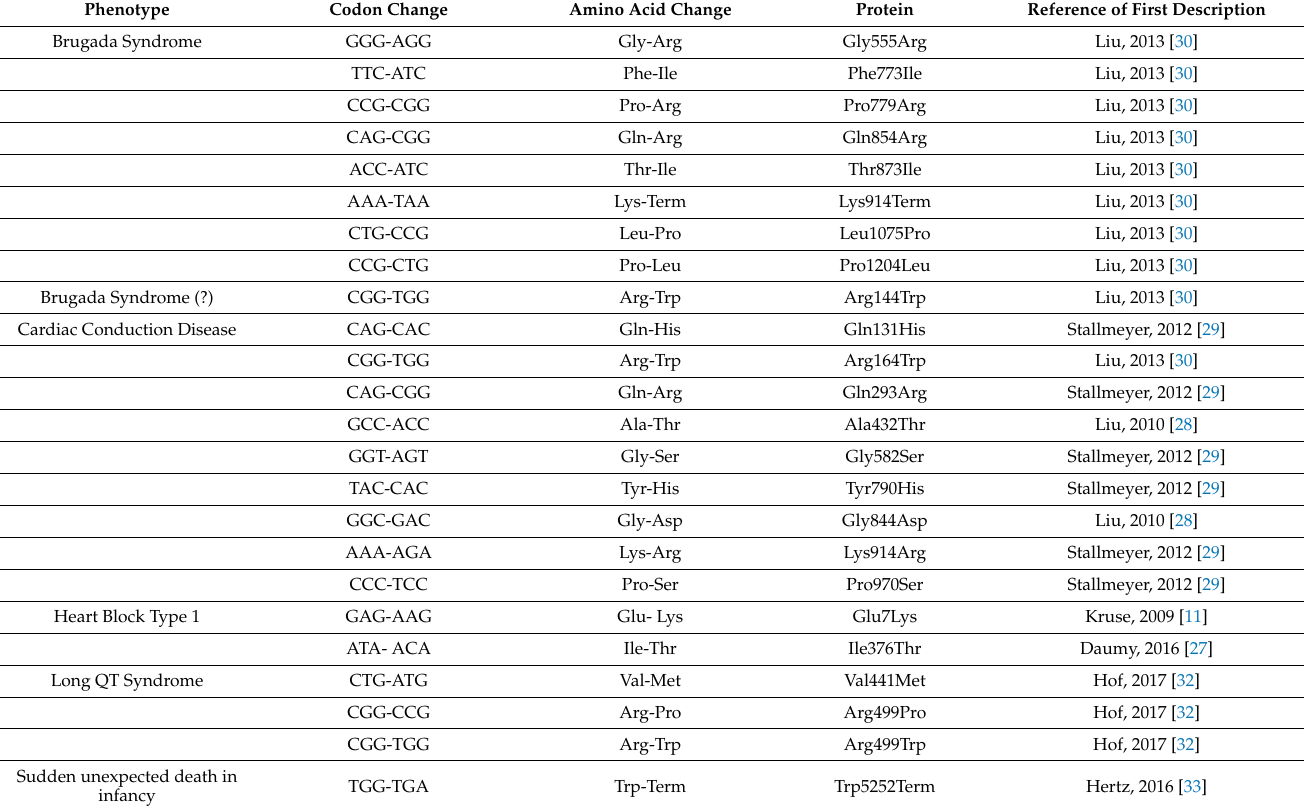
Table 1. List of TRPM4 mutations so far reported in human gene mutation